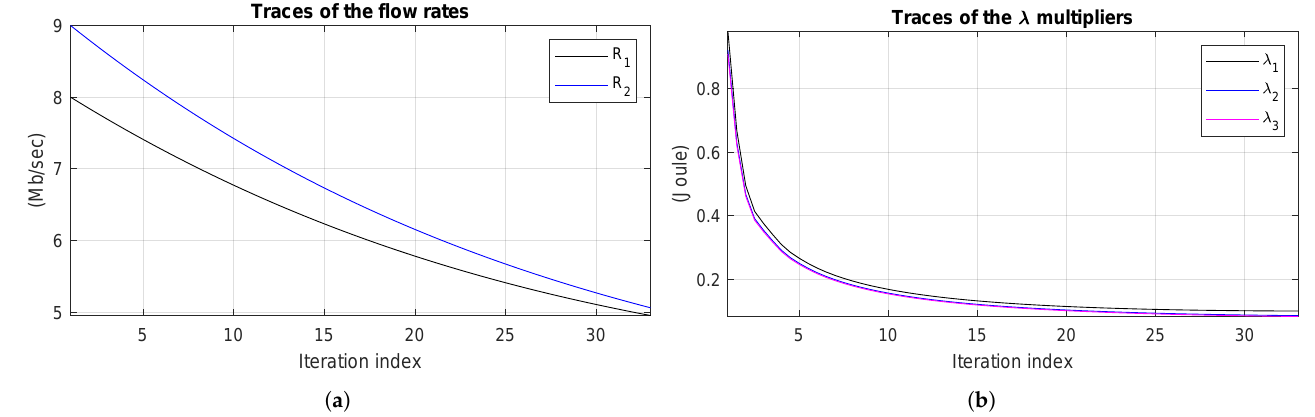
Figure 11. Traces under topology T 1 of the: ( a ) transmission rates and ( b ) Lagrange